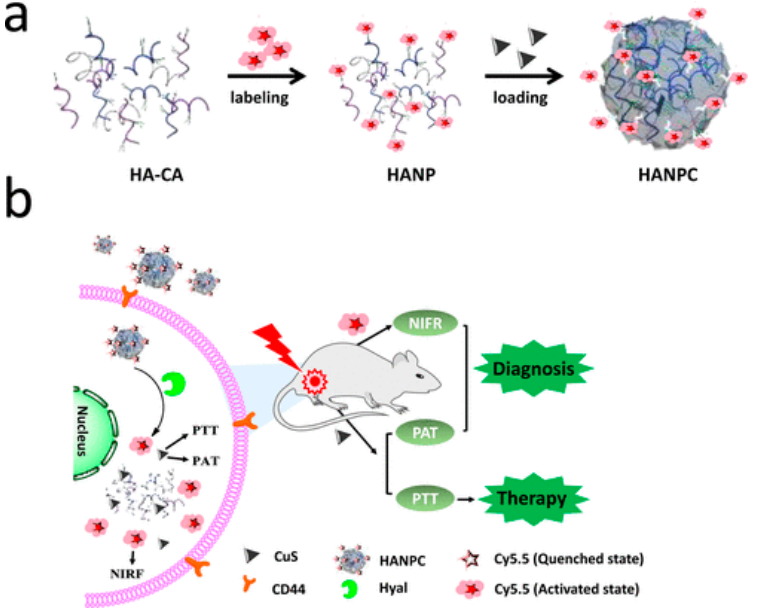
Figure 6. Illustration of ( a ) synthesis of activatable Cy5.5–HANP/CuS (HANPC) nanocomposites, and ( b ) in vivo applications. Reproduced with permission from [112], 2014, American Chemical Society.